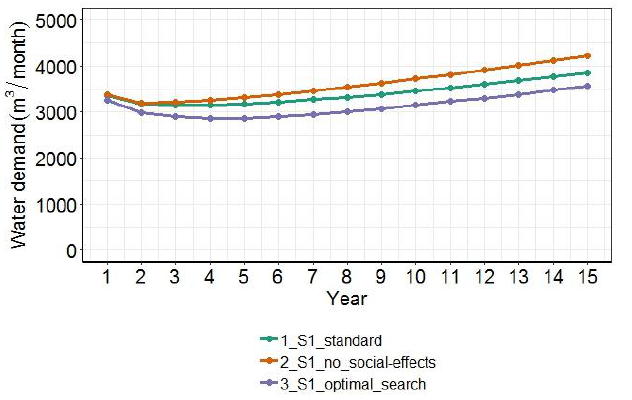
Figure 7. Simulated average water use for variations of the scenario S1. All three variations exhibit an increase in the total water use because the population is growing.